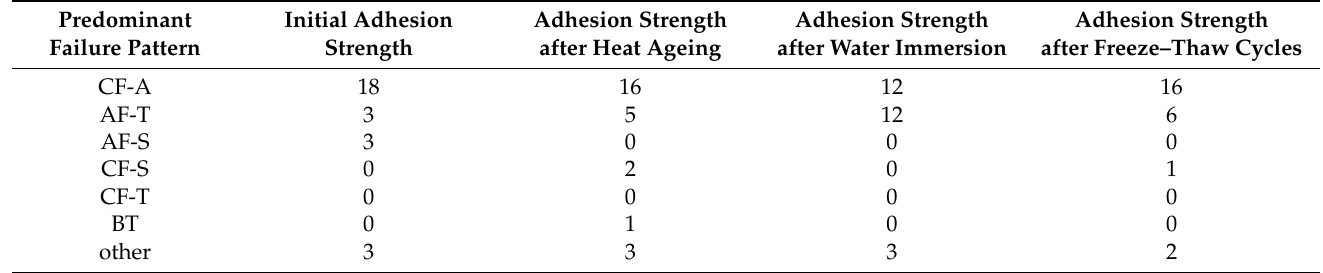
Table 4. The number of the predominant mode of failure for the initial tensile adhesion strength, tensile adhesion strength after heat ageing, tensile adhesion strength after water immersion, and tensile adhesion strength after freeze–thaw cycles of CTA obtained by 27 laboratories participating in the